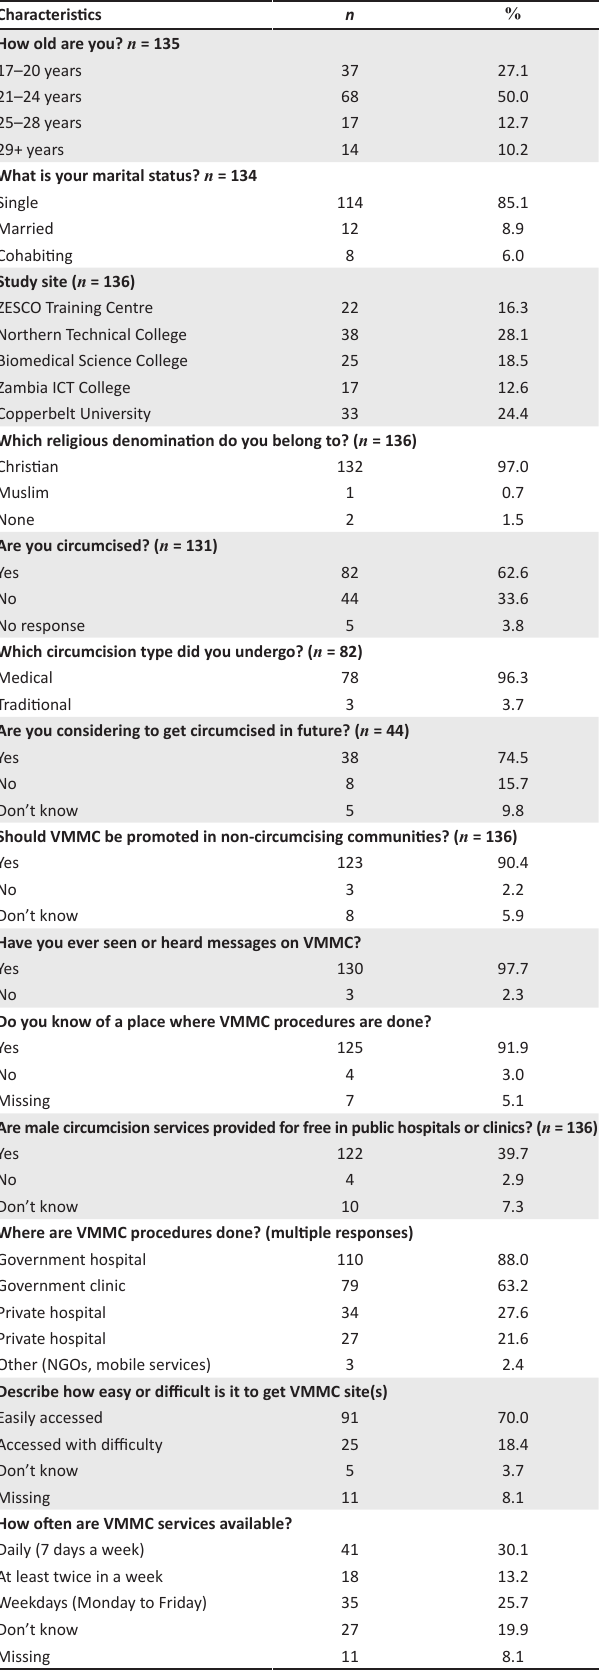
TABLE 1: Demographic characteristics, circumcision status and awareness about medical male circumcision services ( N = 136).